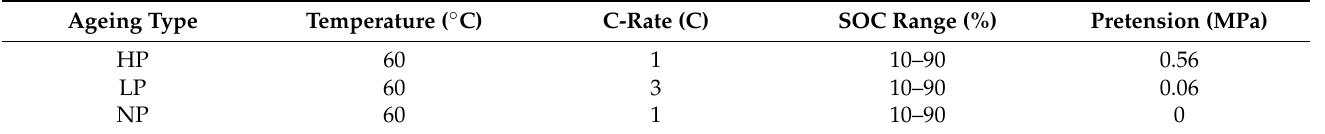
Table 3. Boundary conditions used during battery